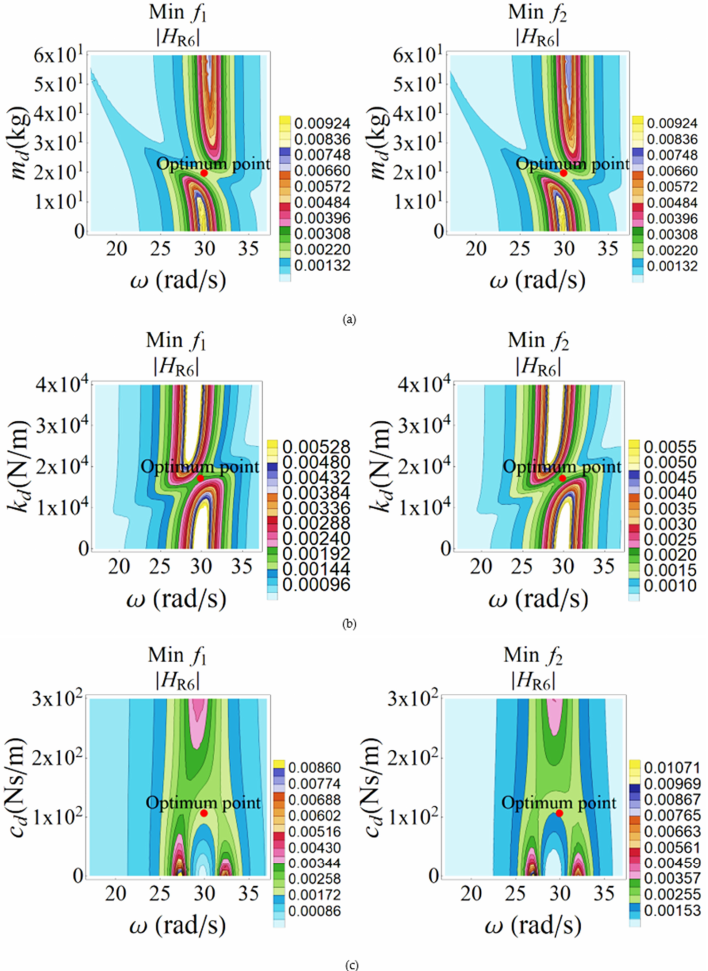
Figure 17. Contour plot of the 6th node rotation absolute transfer function | H R 6 ( ω ) | , with respect to frequency and ( a ) TMD mass coefficient, ( b ) TMD stiffness coefficient, and ( c ) TMD damping coefficient considering 𝑓 (cid:2869) and 𝑓 (cid:2870) minimization for the first mode control.